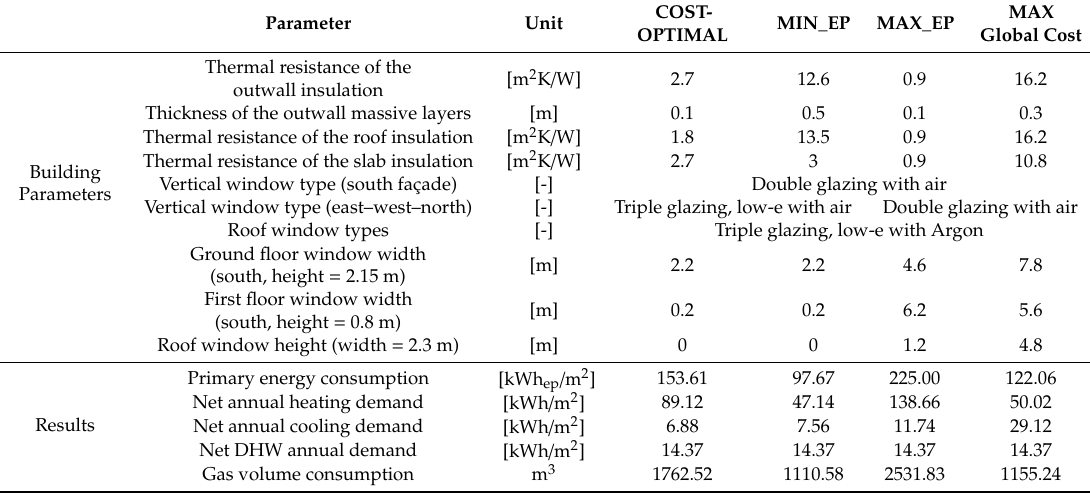
Table 5. Values of parameters of the resulting cost-optimal point and of other significant